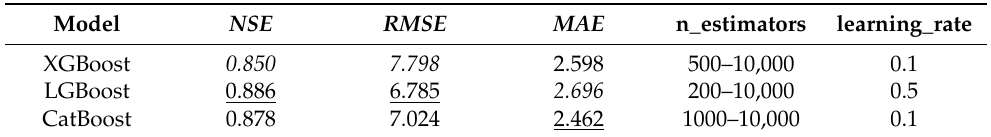
Table 3. Streamflow forecast model performance after hyperparameters optimization. The best results are underlined, the worst are in italic